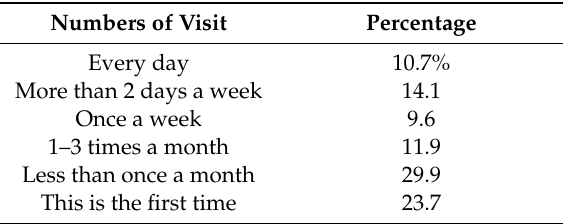
Table 3. Frequency of